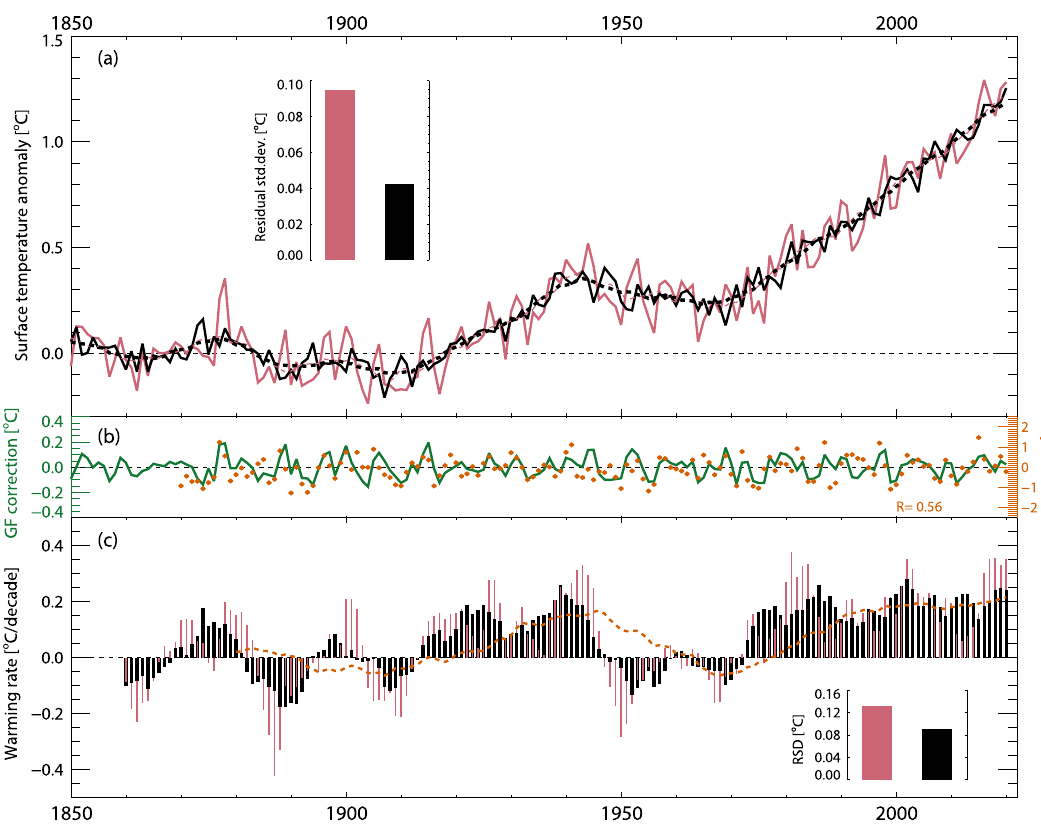
Fig. 2 The effect of Green ’ s function-based fi ltering on global annual mean surface temperature anomalies from HadCRUT5. a Raw (red) and fi ltered (black) HadCRUT5 global mean surface temperature anomaly (GSTA) values, relative to 1850 – 1900. Inset: standard deviation of the residual to a 10-year boxcar average (dashed lines). b The annual mean modulation factors, and the Nino3.4 index for the corresponding year. c 10-year warming rates ending in the year shown, for raw and fi ltered HadCRUT5 GSTA values. The dashed line shows 30-year rates, ending in the same year. Inset: standard deviation of the residuals between the 10-year rates and the 30-year rates (as for the top